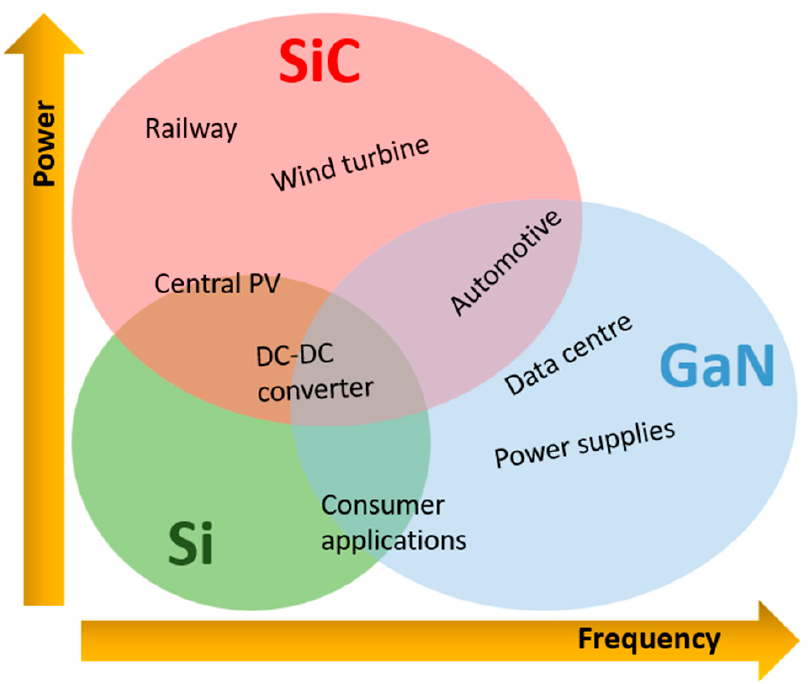
Figure 1. Main application fields of Si, SiC MOSFETs and GaN HEMT devices.